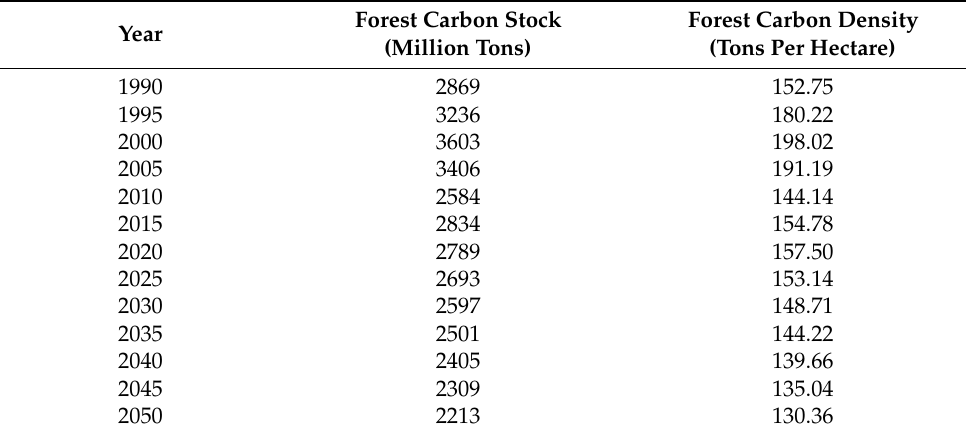
Table 3. Change and prediction in forest biomass carbon stock and average forest carbon density in